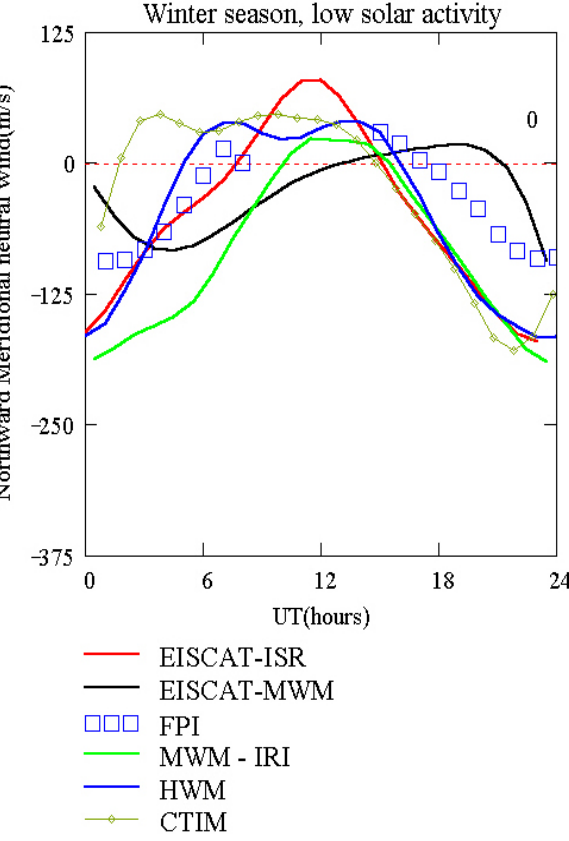
Fig. 3. As for Figure 1 but for autumn season, low solar activity.